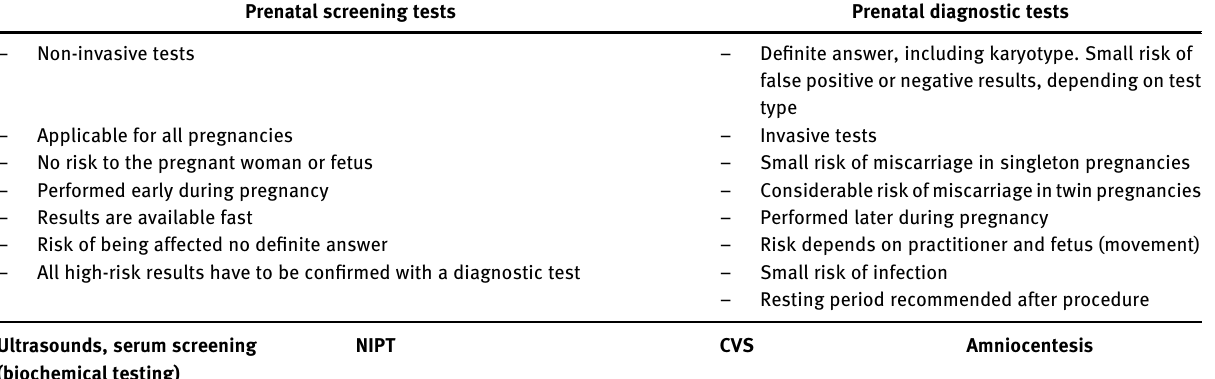
Table  : Comparison of prenatal screening vs. diagnostic